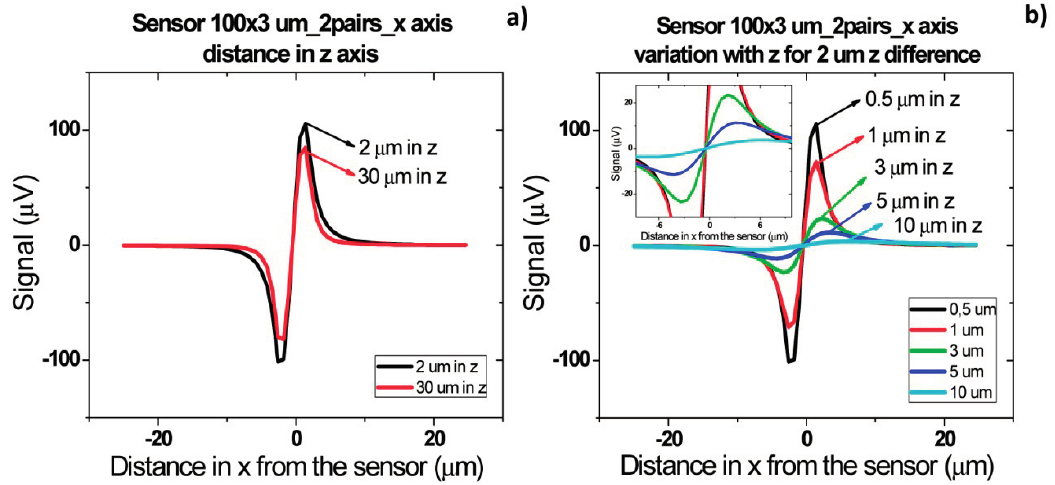
Figure 17. Signal simulation for two Streptococcus agalactiae along z axis. ( a ) Cells at a given distance along z axis; ( b ) Signal variation with height from the sensor for cells at 2 μ m distance from each other along z axis.